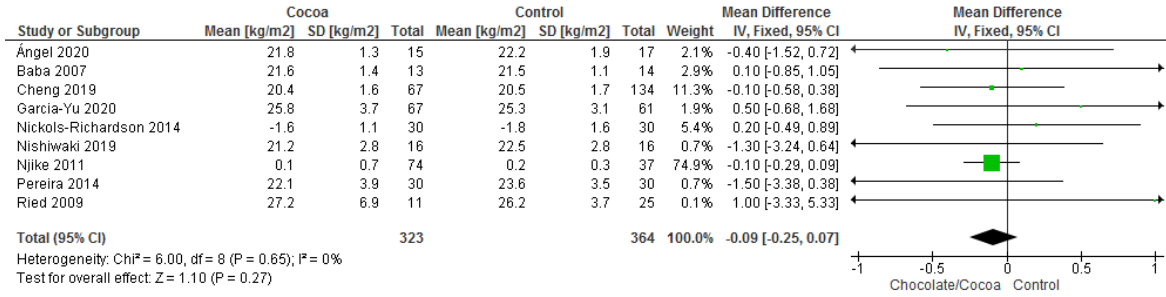
Figure 10. Forest plot of comparison: chocolate versus control, with the outcome—body mass index (kg/m 2 ). Nichols- Richardson (2014) and Nijike (2011) reported mean changes and their respective SD, instead of mean scores.